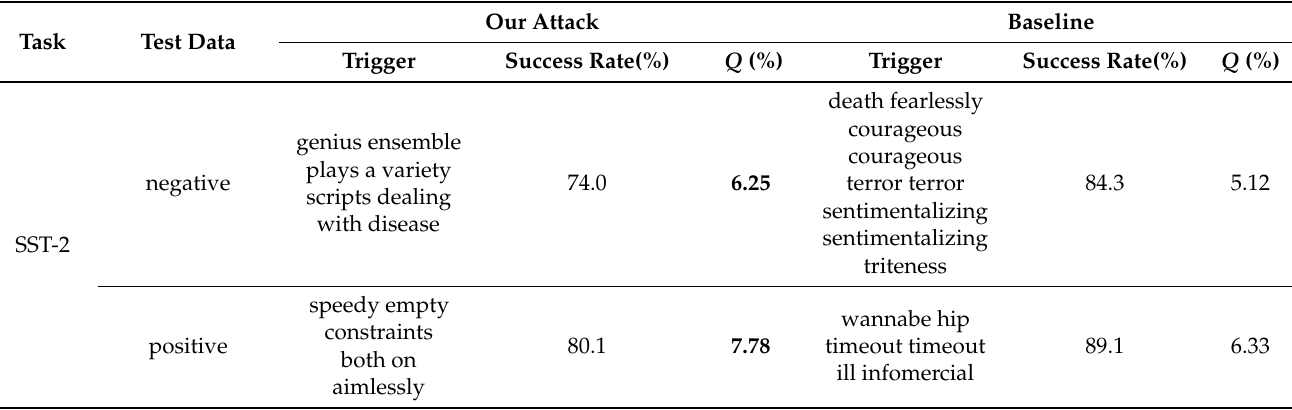
Table 2. Universal attack results. The composite score Q of our attack is higher than the baseline method. Our attacks are slightly less successful in terms of attack success rate but generate a more natural trigger. Task Test